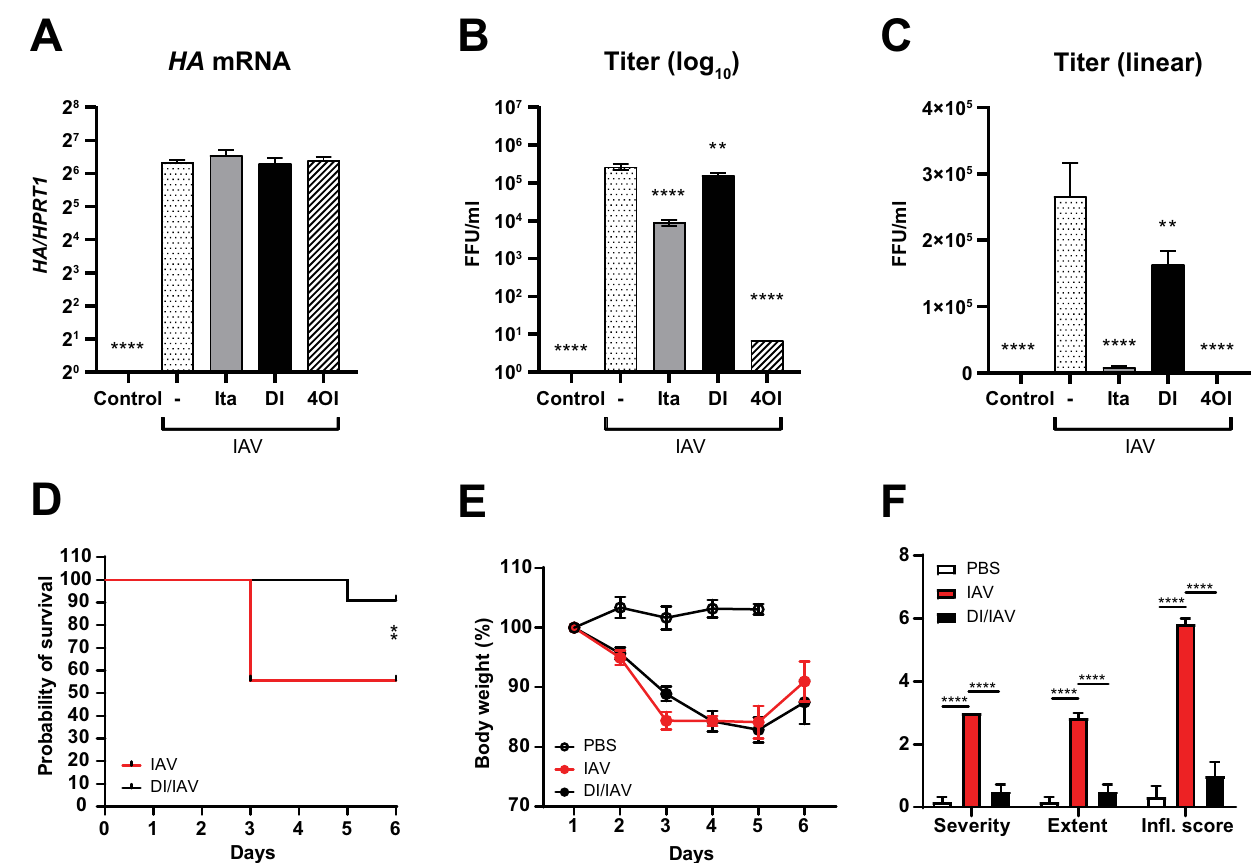
Fig 11. A-C . Itaconates differ greatly in the ability to reduce progeny virions in productive IAV infection. A549 cells were infected with IAV PR8M (MOI = 1) and treated with itaconate (20 mM), DI (0.5 mM) or 4OI (125 μ M) as indicated. HA mRNA and viral titers were measured 24 h p.i. A. HA mRNA (RT-qPCR). B,C. A549 cells, titers in culture supernatants (foci-forming assay) 24 h p.i. expressed on log 10 (B) or linear (C) scale. D-F . DI treatment increases survival and prevents pulmonary inflammation in the mouse model of IAV infection. 6–8 week-old female C57Bl/6J mice were infected with 1x10 3 FFU of mouse-adapted IAV (A/PR/8/34) and injected once daily with DI (50 mg/Kg intraperitoneally) for 5 days (n = 9), the first dose being given the day before infection, or PBS (n = 11). Body weight was determined daily and mice were sacrificed 5 d p.i. (PBS mock infection) or 6 d p. i. (IAV infection). D. Survival curve indicating higher survival in the DI-treated group ( p = 0.0097, 2-tailed t test). E. Weight loss curves indicating no effect of DI treatment on body weight. F. Pulmonary inflammation scores (H&E stained sections; same score as used in Fig 1) in randomly selected samples (n = 6 per group). DI treatment prevented pulmonary inflammation nearly completely. Representative histological findings are shown in S25 Fig . Viral titers in lung homogenates (7.0x10 6 vs. 8.9x10 6 FFU) did not differ significantly between treated and untreated IAV-infected mice ( p = 0.8, two-tailed t test, n = 3 randomly selected samples per